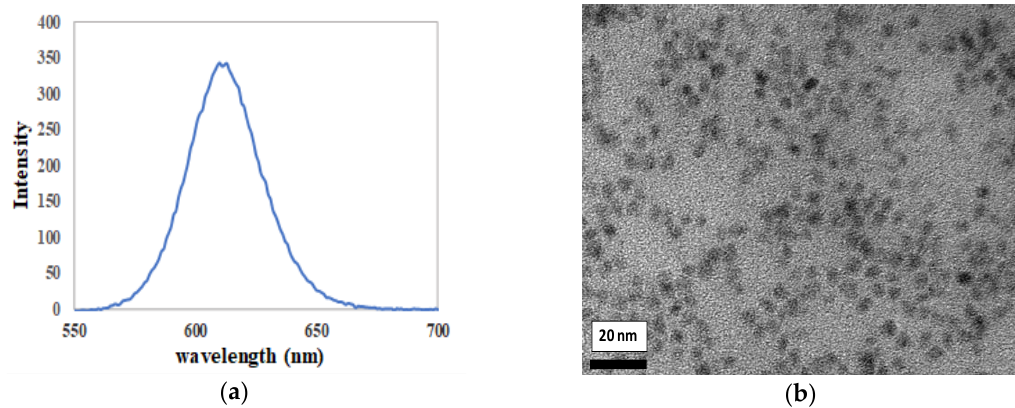
Figure 2. ( a ) Fluorescence emission of CdSe/ZnS QD excited at 365 nm; ( b ) high-resolution transmission electron microscopy (HRTEM) of CdSe/ZnS QD at magnification of 200 k.